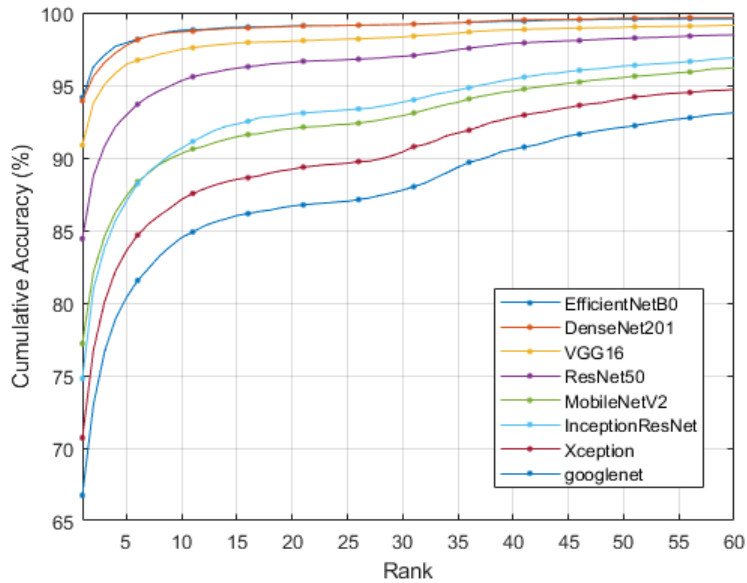
90.87 Table 5. Performance comparison of using DenseNet-201 and Efficientnet-B0 as backbone model for LDA-CNN model. The results were obtained using UFPR dataset.